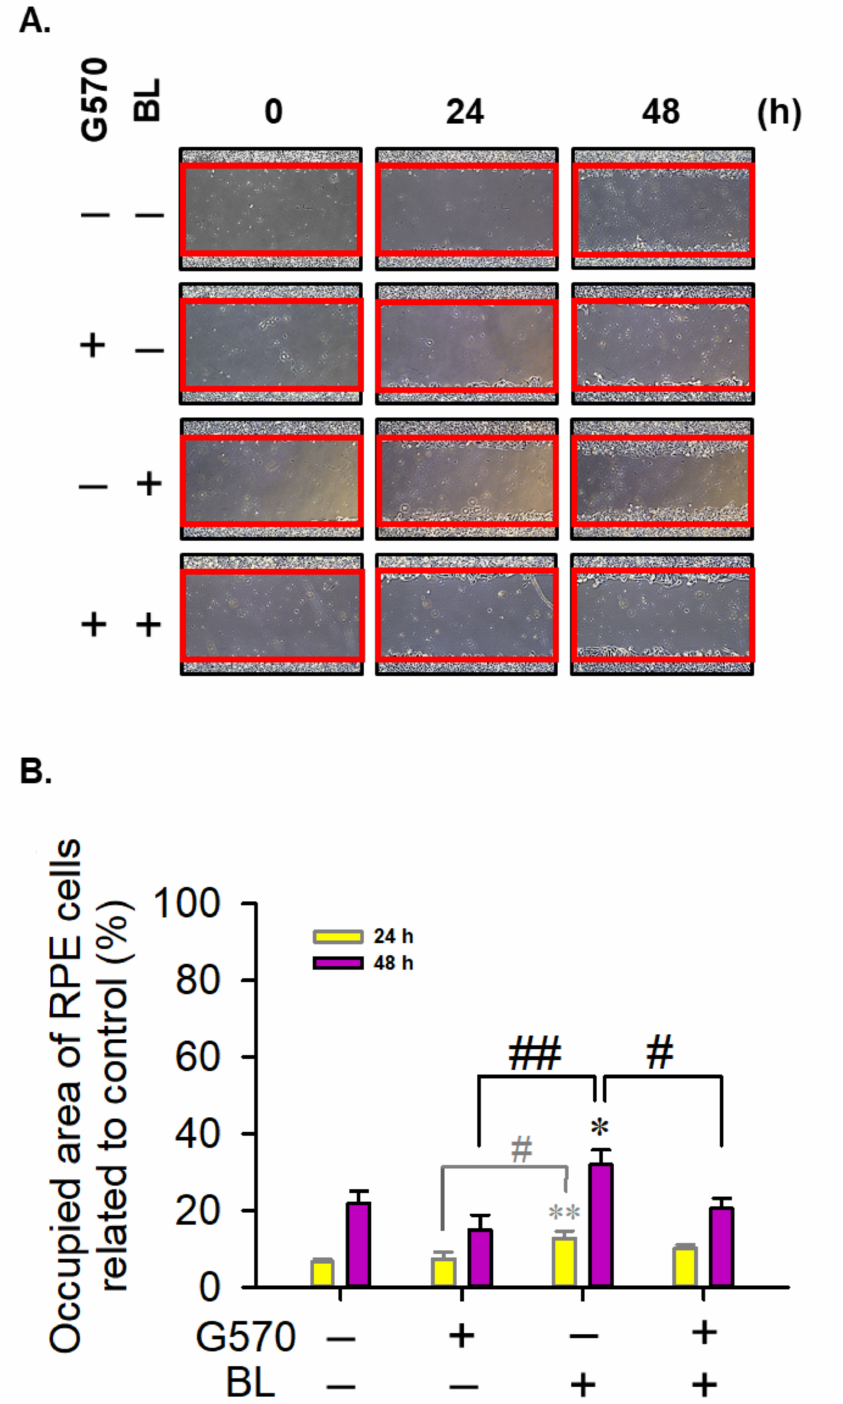
Figure 3. Cell migration assay in ARPE-19 cells. The cells were seeded in a 3.5 cm dish. Each group was exposed to 150 lux BL and treated with 0.5 µ M G570. After 24 and 48 h, ARPE-19 cells were observed and recorded by an Olympus IX70 inverted tissue culture microscope and an SGHD-3.6C charge-coupled device (CCD) imaging system (SAGE Vision, New Taipei City, R.O. C), respectively. ( A ) The cell migration images of ARPE-19 cells. ( B ) The occupied area of ARPE-19 cells in different groups. Data are expressed as the mean ± S.D. and were obtained in triplicates. Significance was estimated compared to the control, where p * ≤ 0.05, p ** ≤ 0.01, p # ≤ 0.05, and p ## ≤